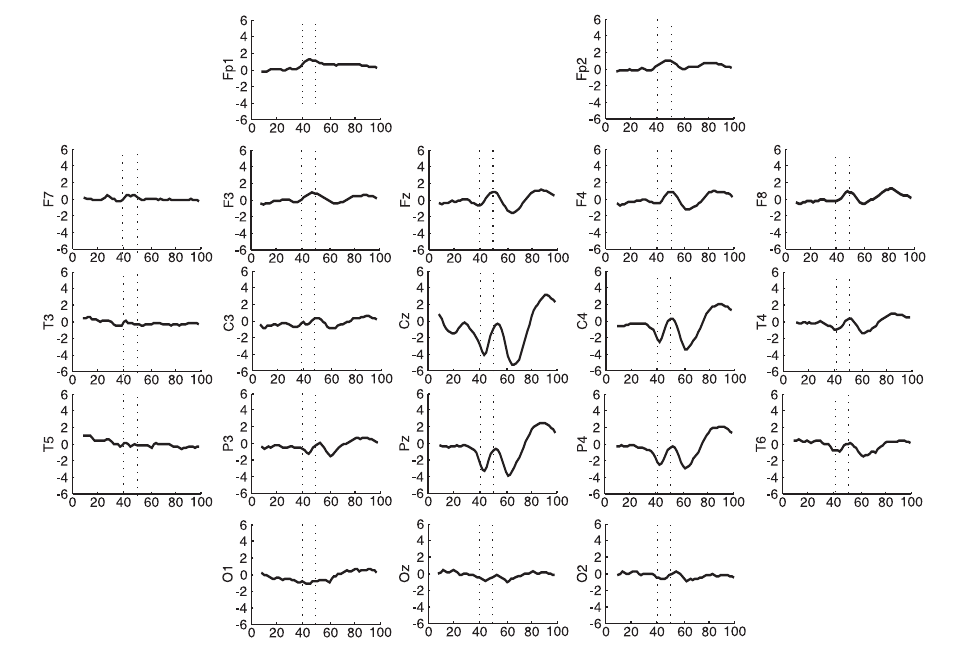
Figure 2. Somatosensory evoked potential topography of volunteer #5 stimulated at 22 mA. Time scale (abscissa) in ms and amplitude scale (ordinate) in µV. Vertical dotted lines indicate 40 and 50 ms, respectively.